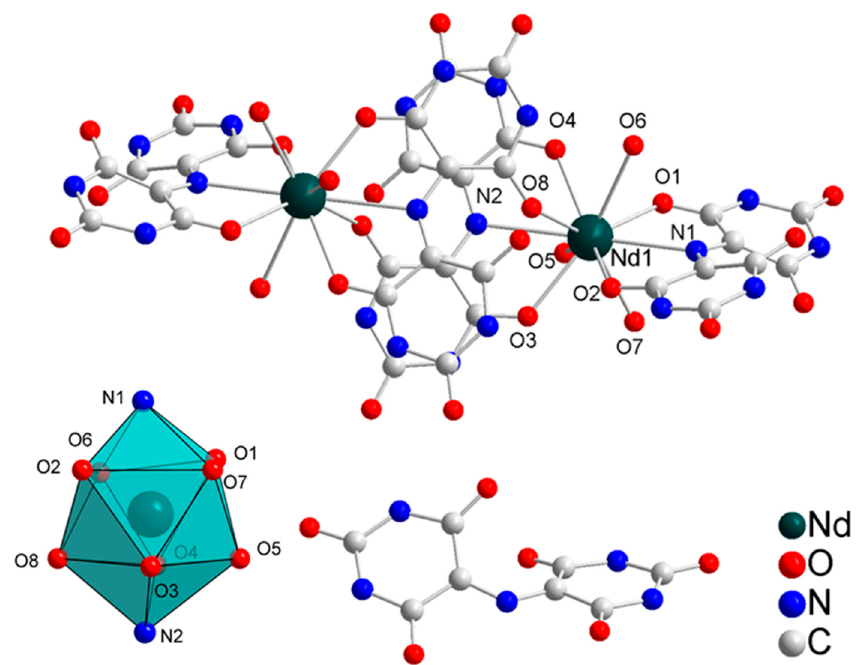
Figure 1. The best view of NdMurex with one of the two free murexide molecules and labeling scheme. Inset view of the Nd1 coordination polyhedron. Hydrogen atoms and water molecules are omitted for clarity.